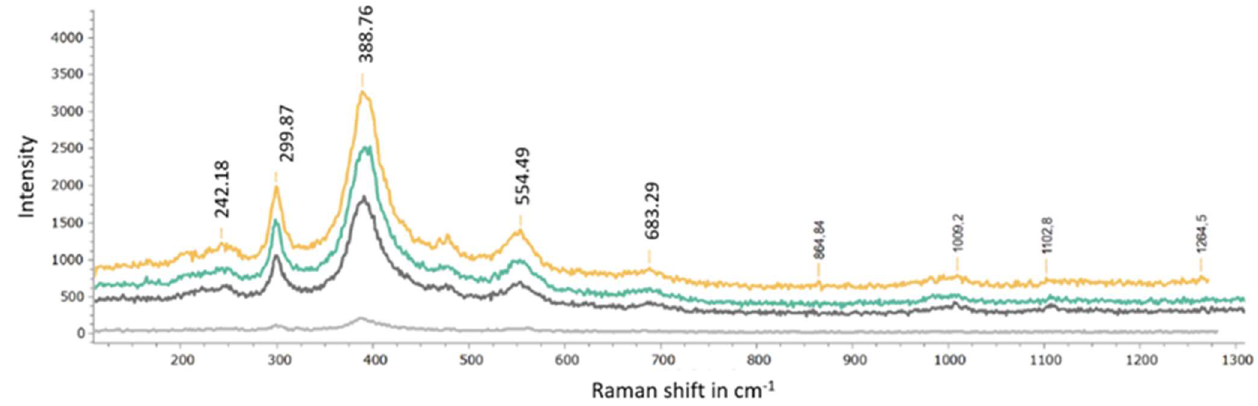
Figure 17. Overlayered spectra acquired from samples of Stefføya. Goethite presence in the samples, along with jarosites, is confirmed.